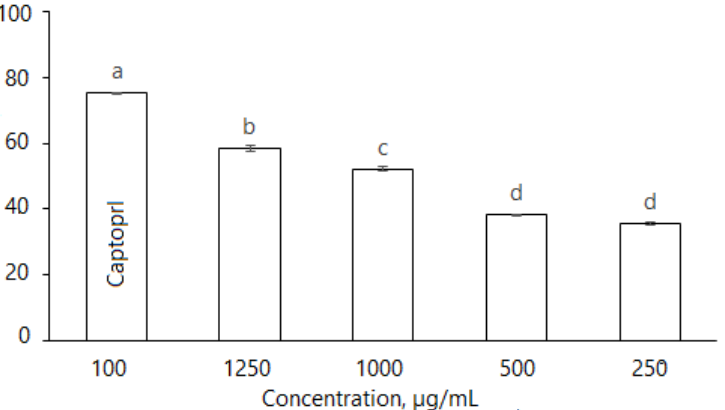
Figure 6. Inhibition of ACE by D. caucasica 70% ethanol leaf extracts at different concentrations (Captopril—positive control; negative control—no inhibition). Enzyme inhibition was expressed as percentage versus control (100%) (Control = 0 inhibition). The values are the means ± standard error (SE) ( n = 3). The values with different letters are significantly different, according to Fisher’s LSD test ( p < 0.05) after one-way ANOVA.